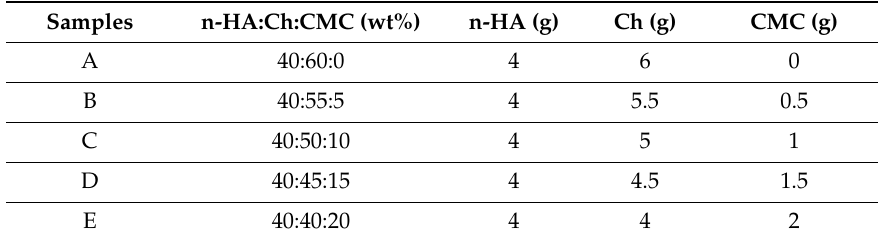
Table 1. Composition details of nano-hydroxyapatite (n-HA), chitosan (Ch), and carboxymethyl cellulose